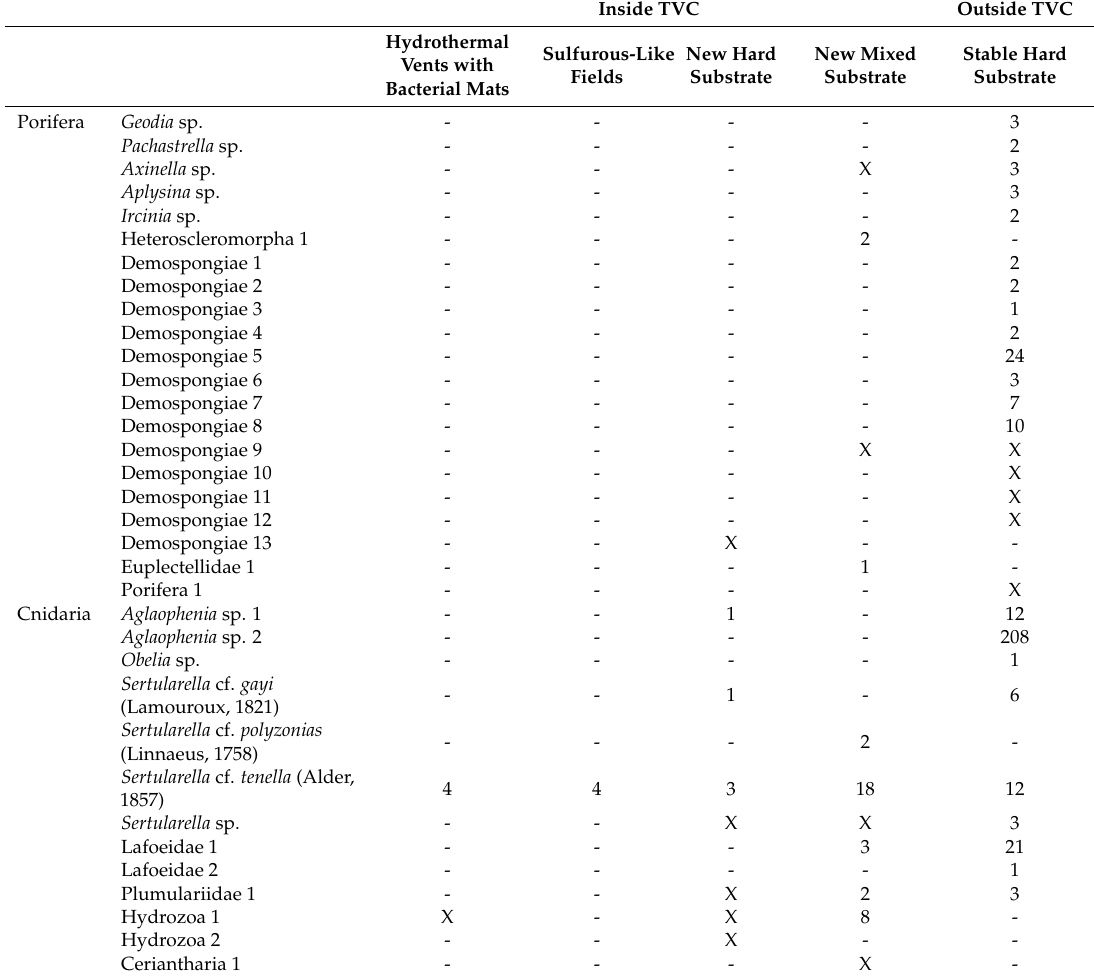
Table 1. List of all taxa identified in different habitat types of the Tagoro volcanic complex (TVC), with adjacent non-buried bottoms in the underwater images (ROV, VOR) and benthic dredges. Abundance is only shown for dredge-sampled taxa. X indicates the presence of taxa in the underwater images. Inside TVC Hydrothermal Vents with Bacterial Mats Porifera Geodia sp.